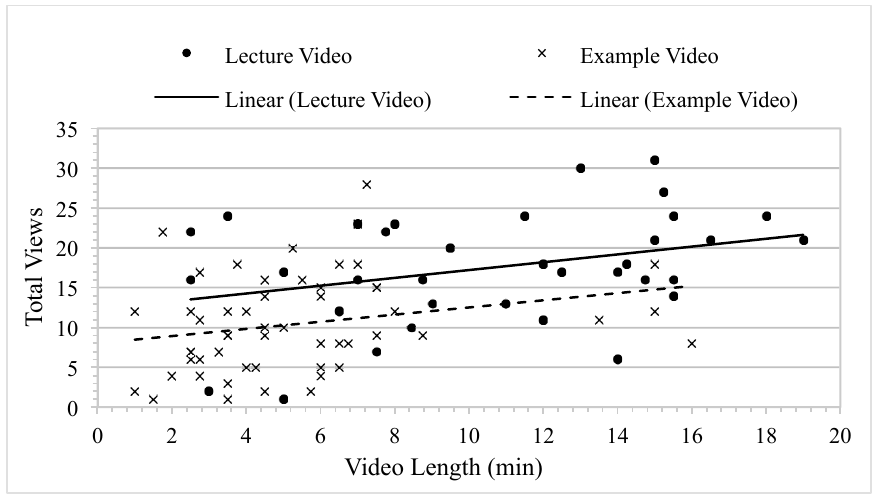
Fig. 9. Total Views vs. Video Length.